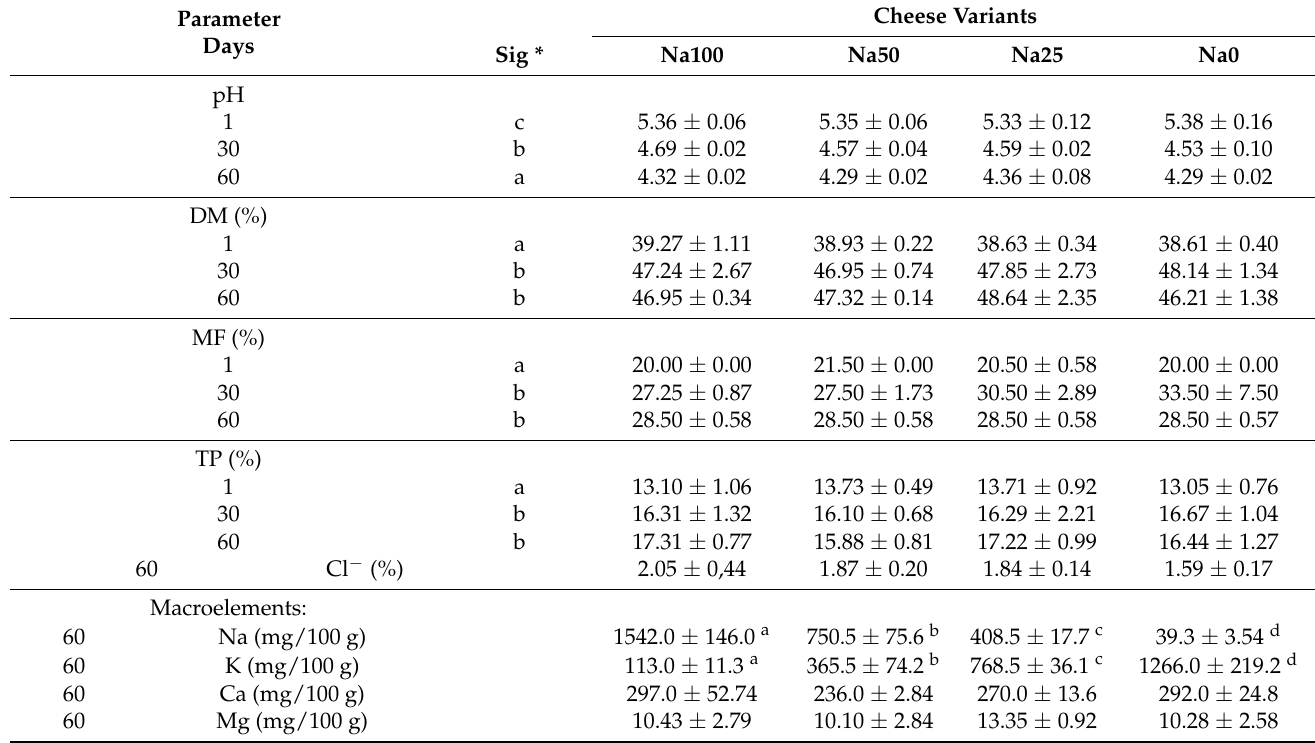
Table 2. Basic composition and macroelements of white brined cheese manufactured with different ratios of NaCl and KCl after 1, 30 and 60 days of